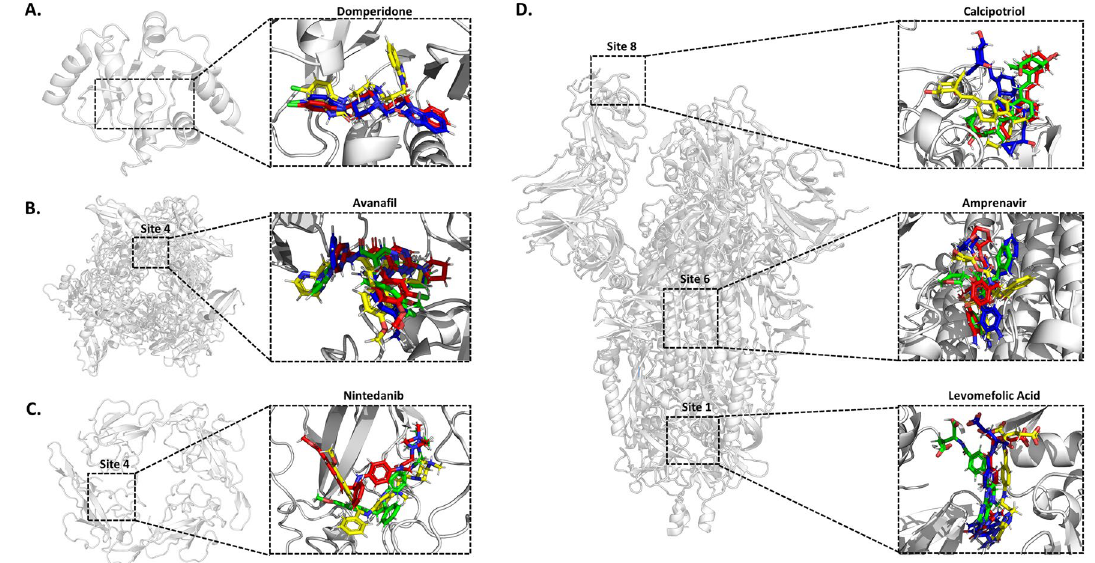
Figure 4. Final snapshots from molecular dynamics simulations for stable drug-site systems. The docked drug pose is shown in yellow, while the final pose after three independent 100 ns molecular dynamics simulations is shown in red (1), green (2), and blue (3). ( A ) ADRP domain of NSP3 with domperidone docking and final molecular dynamic simulation poses. ( B ) Site 4 of NSP15 with Avanafil docking and final molecular